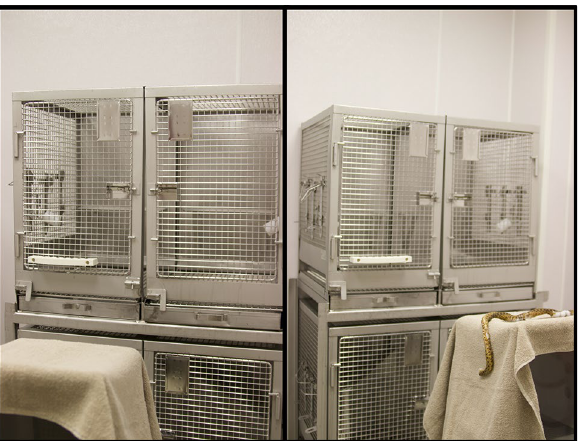
Figure 1. The test cage and platform during the sham control trial and full snake stimulus